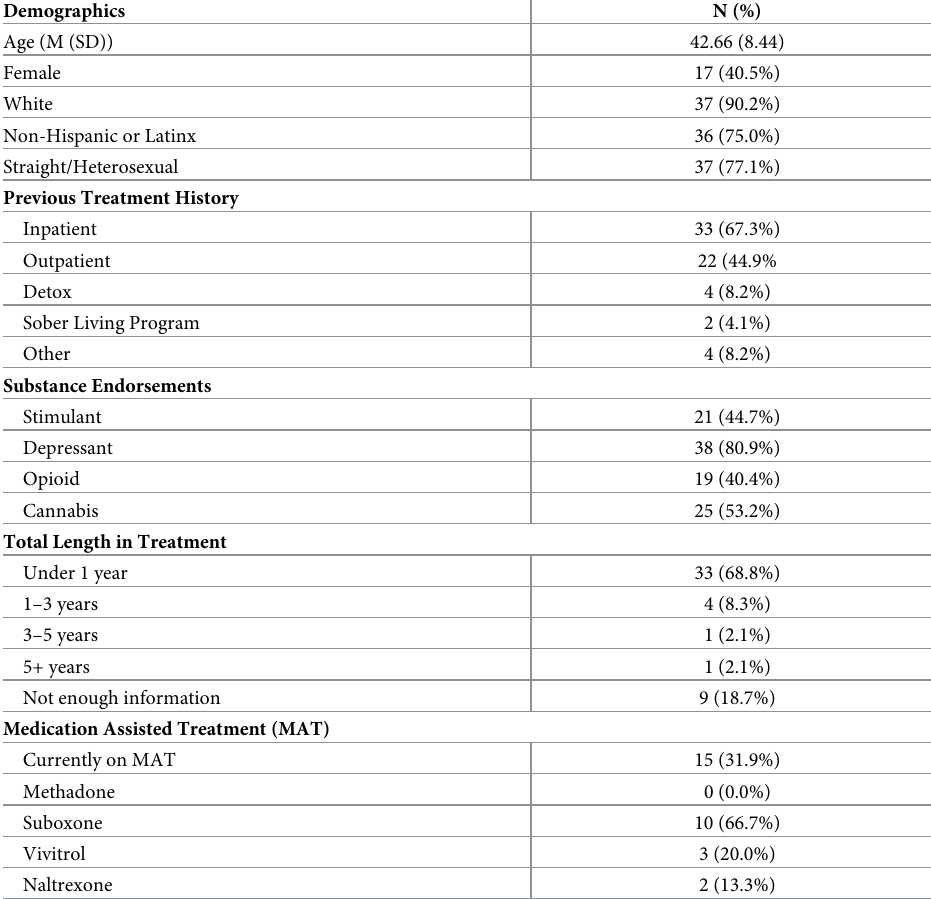
Table 1. Sample characteristics (N =